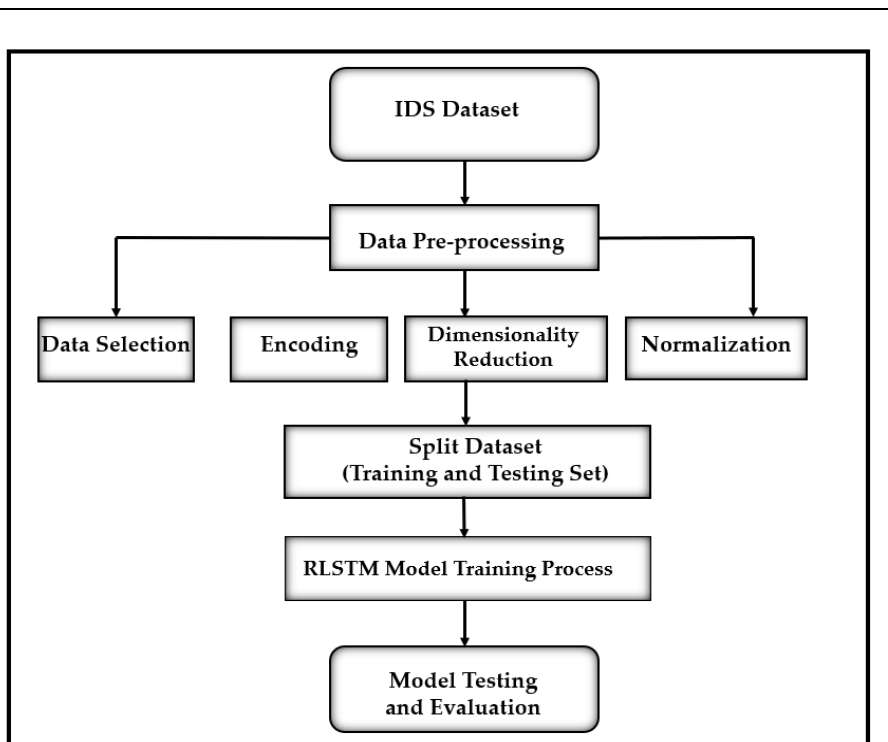
Figure 1. The proposed RLSTM flowchart. Table 1. RLSTM parameters.